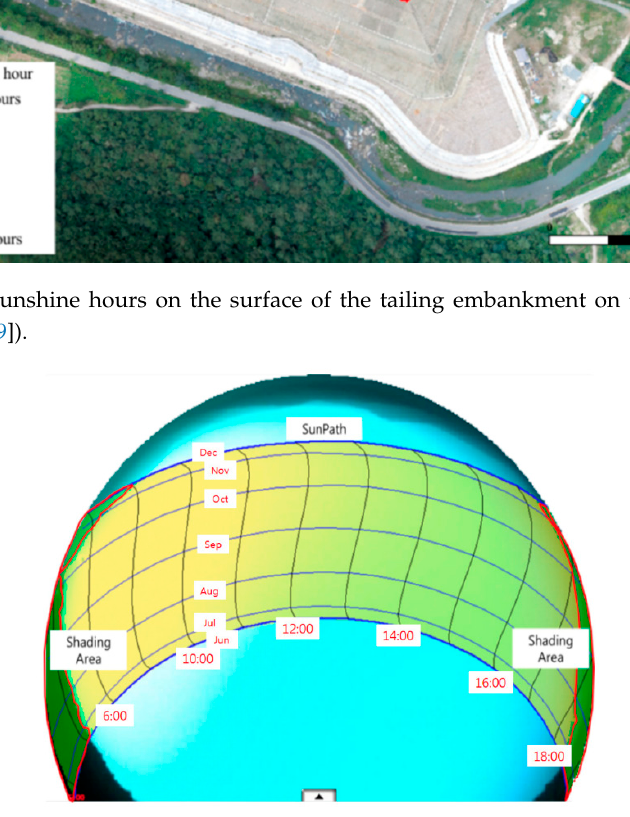
Figure 10. Results of shading analysis using a fish-eye lens camera (Sun Eye 210) (Choi and Song [79]). Table 4. Shading matrix generated from the onsite solar assessment (Choi and Song [79]).